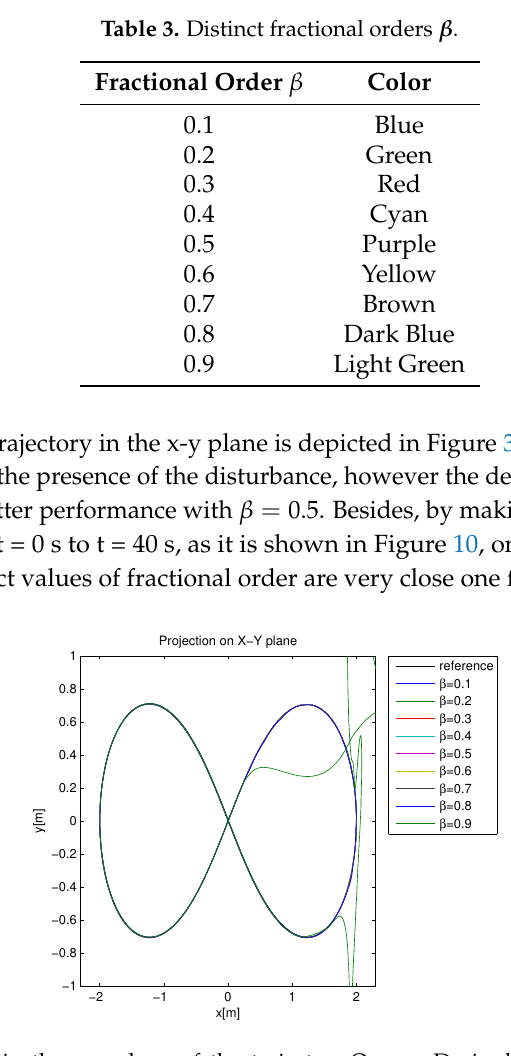
Figure 3. Projection in the x-y plane of the trajectory.Orange-Desired trajectory, Else-Trajectory being